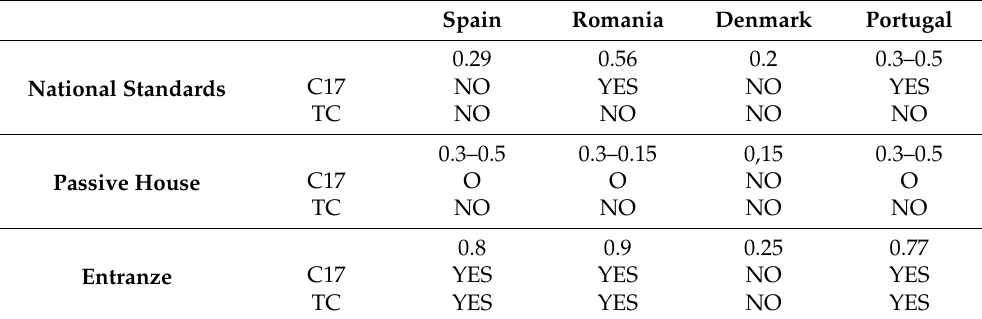
Table 13. Thermal transmittance in walls coefficient (W/m 2 K)